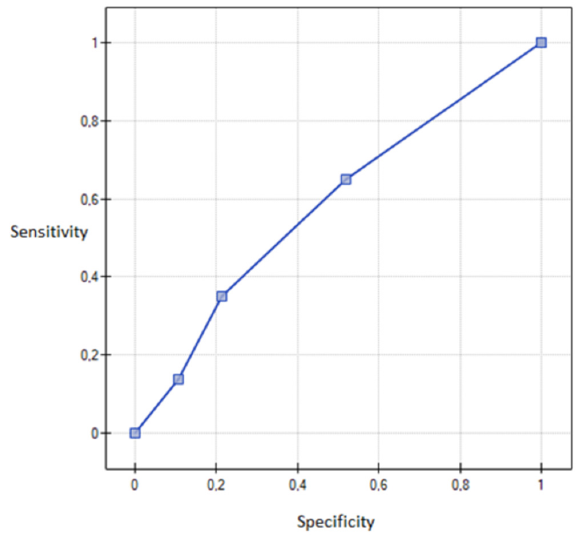
Figure4. Relationship betweenthe extent of surgery (resectionor sparing ofthe cervix) and deterioration Figure 4. Relationship between the extent of surgery (resection or sparing of the cervix) and deterioration Figure 4. Relationship between the extent of surgery (resection or sparing of the cervix) and deterioration Figure 4. Relationship between the extent of surgery (resection or sparing of the cervix) and deterioration of the quality of women’s sexual lives after surgery. Results are presented as percentages (%). of the quality of women's sexual lives after surgery. Results are presented as percentages (%). of the quality of women's sexual lives after surgery. Results are presented as percentages (%). of the quality of women's sexual lives after surgery. Results are presented as percentages (%).